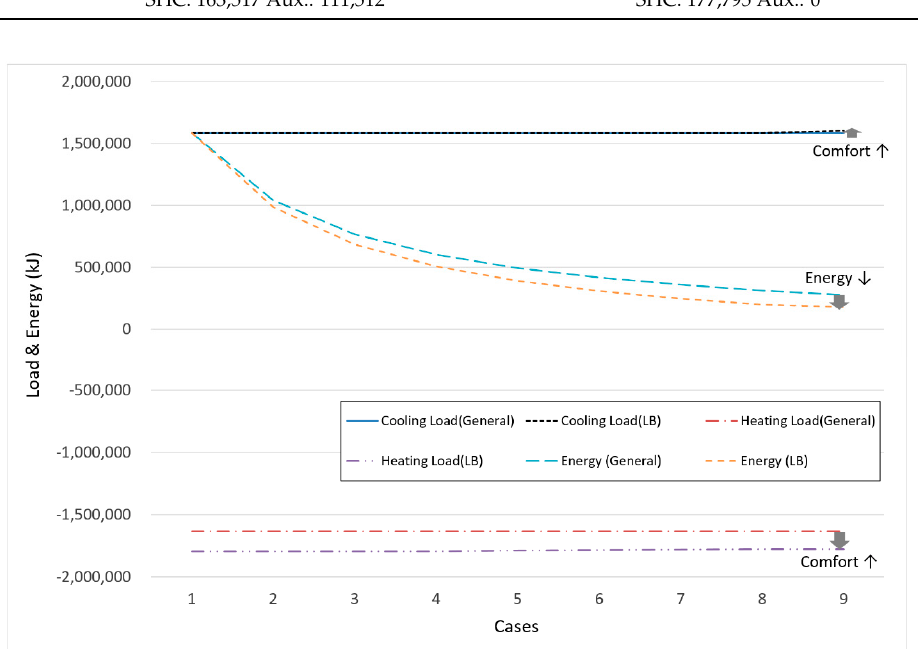
Figure 5. Removed load and energy consumption (Cases 1 − 2 − 1~1 − 2 − 9).